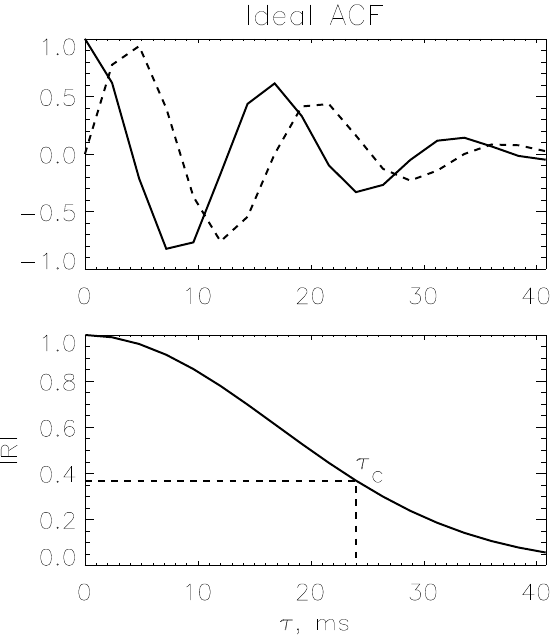
Fig. 3. Ideal ACF characteristics from SuperDARN radars. (Top) The real part (solid) and imaginary part (dashed) of a normalised, ideal ACF. The ACF magnitude (bottom) showing the correlation time scale, τ c , which is used to calculate spectral width, W .